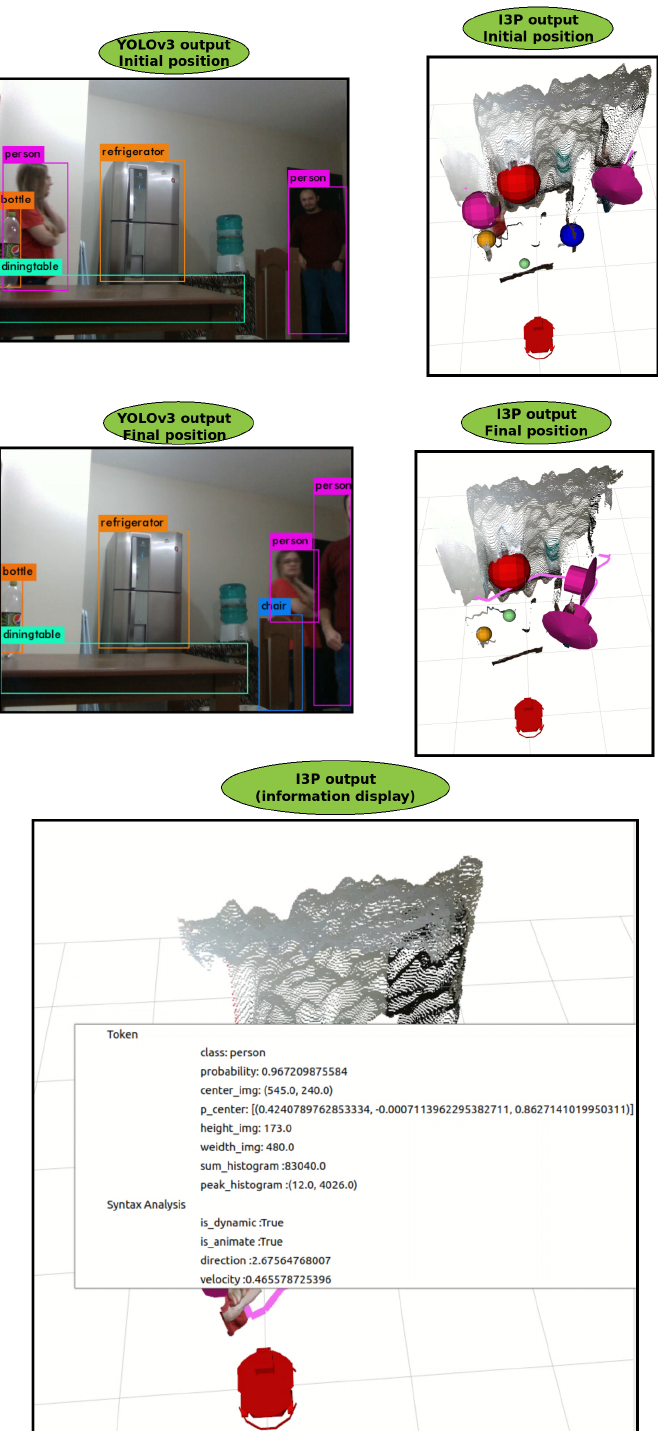
Figure 9. Result of the application of the Syntax